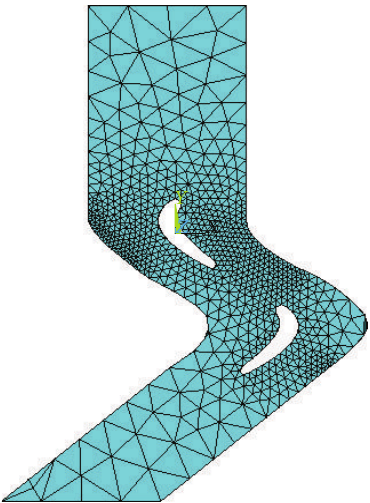
Figure 9: The ANSYS model of the turbodrill